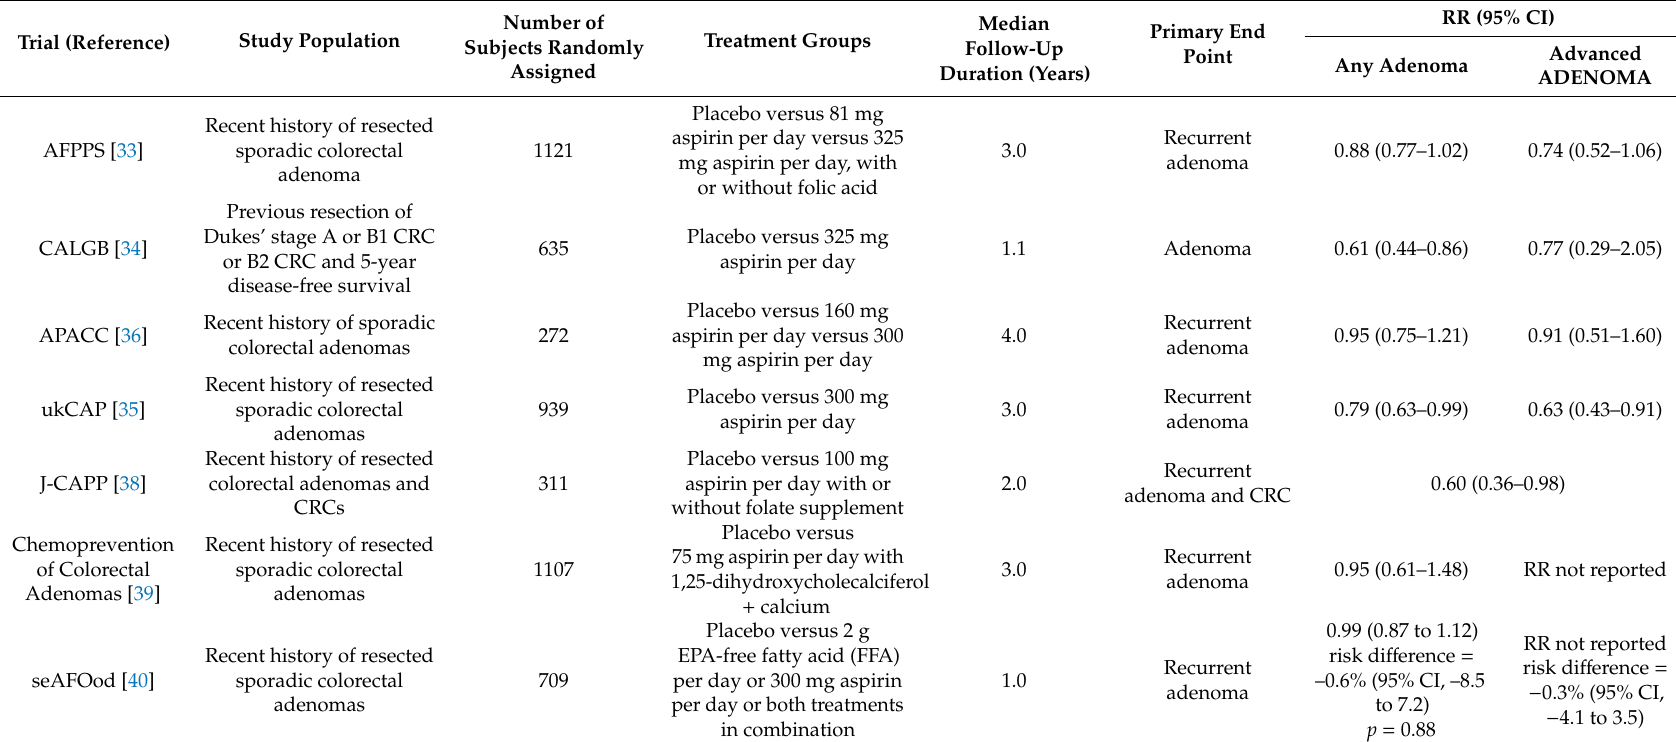
Table 2. Placebo-controlled trials of aspirin for the prevention of recurrent adenoma and colorectal cancer